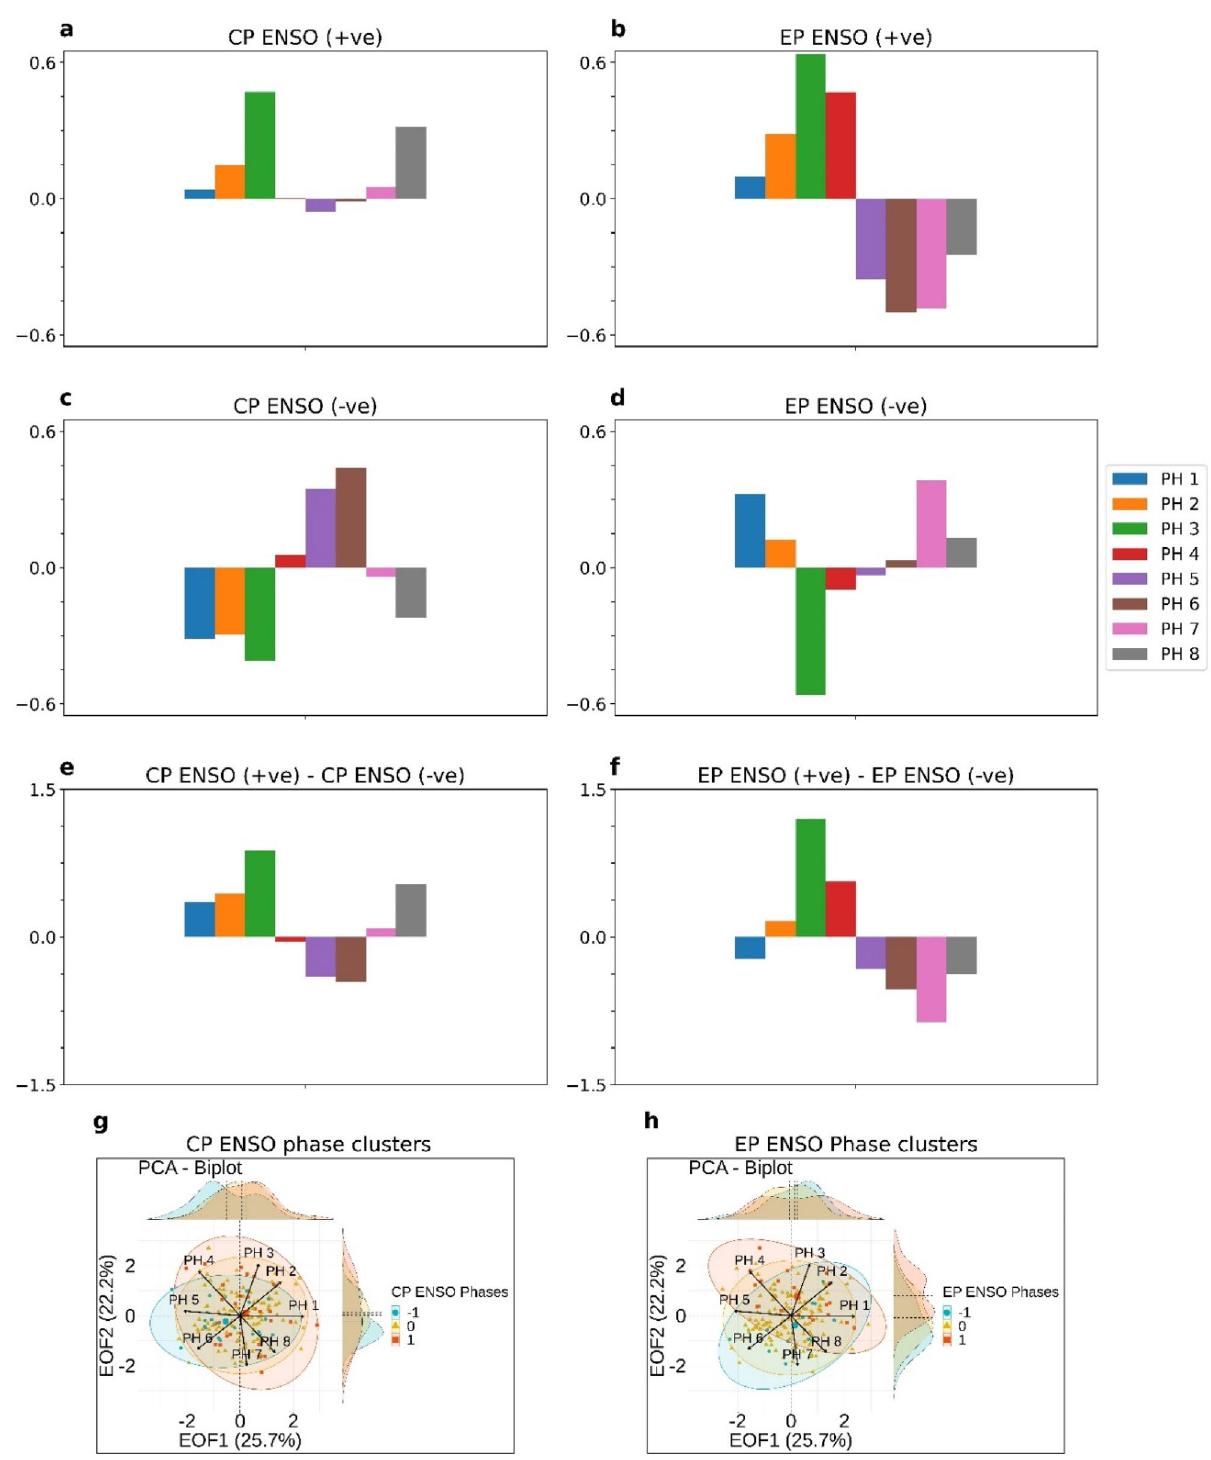
Figure 3. Composites of MJO frequency anomalies (standardized) at 8 RMM phase regions during ( a ) Positive CP-type ENSO seasons, ( c ) Negative CP-type ENSO seasons and their differences ( e ). Similarly, composites for ( b ) Positive EP-type ENSO seasons, ( d ) Negative EP-type ENSO seasons and their differences ( f ). ( g ) PCA biplot and clusters of positive (red), negative (blue) and neutral (yellow) CP-type ENSO seasons. Data ellipses represent the statistics of different classes. ( h ) Similar as the figure ( g ) for positive, negative and neutral EP-type ENSO